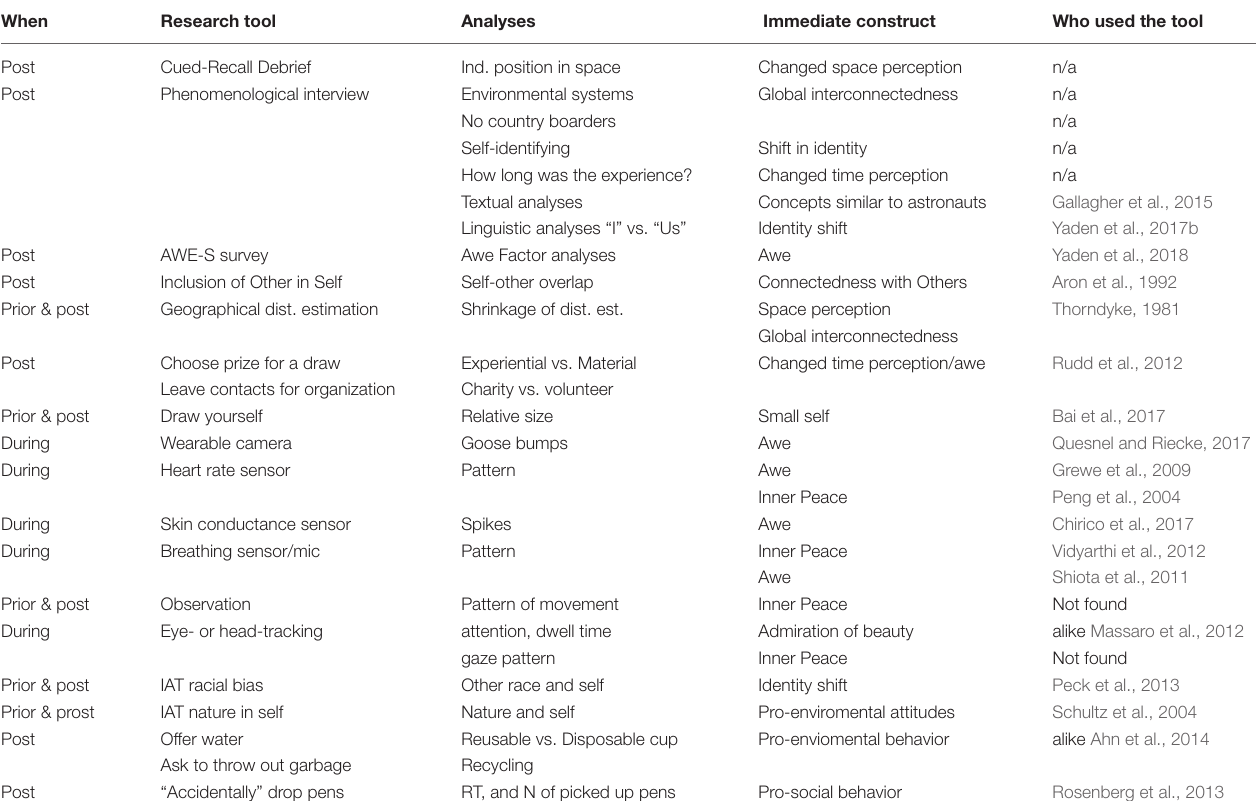
TABLE 1 | Summary of proposed evaluation